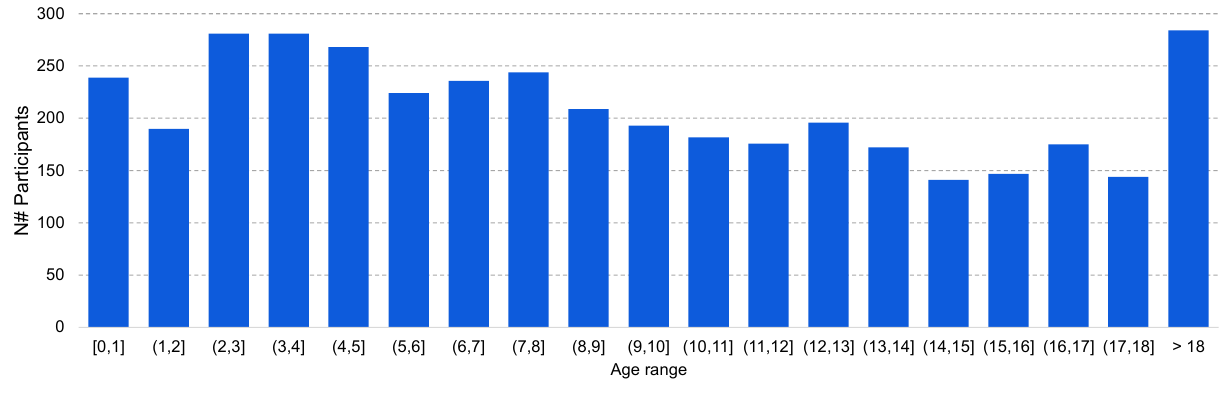
Figure 1. Distribution of the NCH dataset over different age ranges.